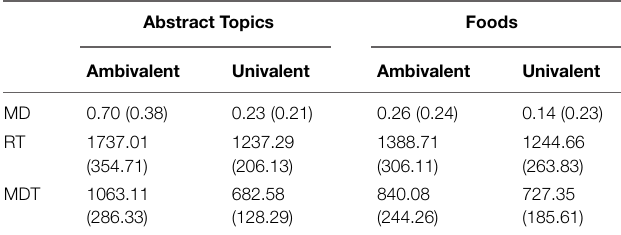
TABLE 2 | Study 3 means (SD) for maximum deviation (MD), response time (RT), and maximum deviation time (MDT) for ambivalent vs. univalent stimuli, for abstract topics and foods